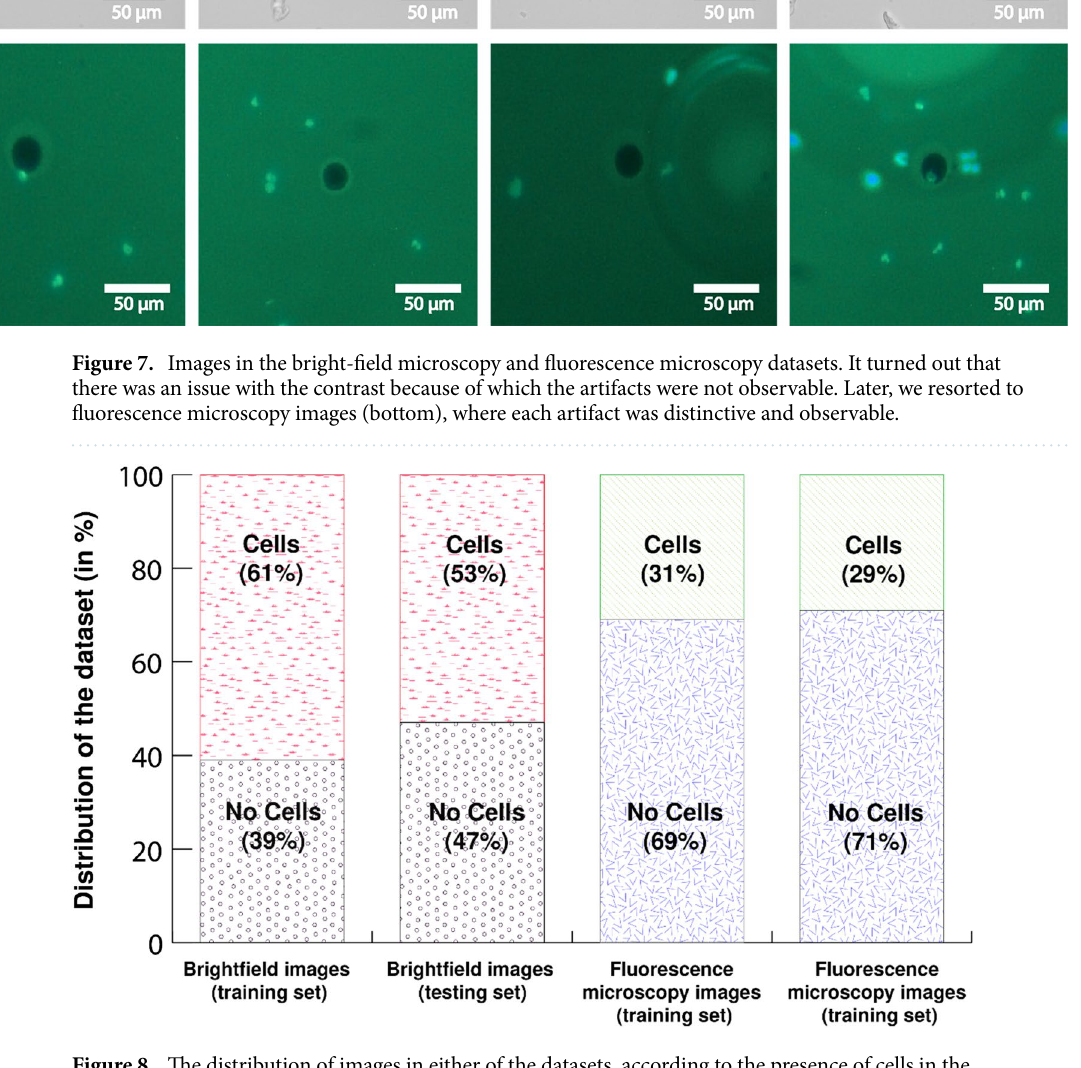
from the images and learn the features efficiently.